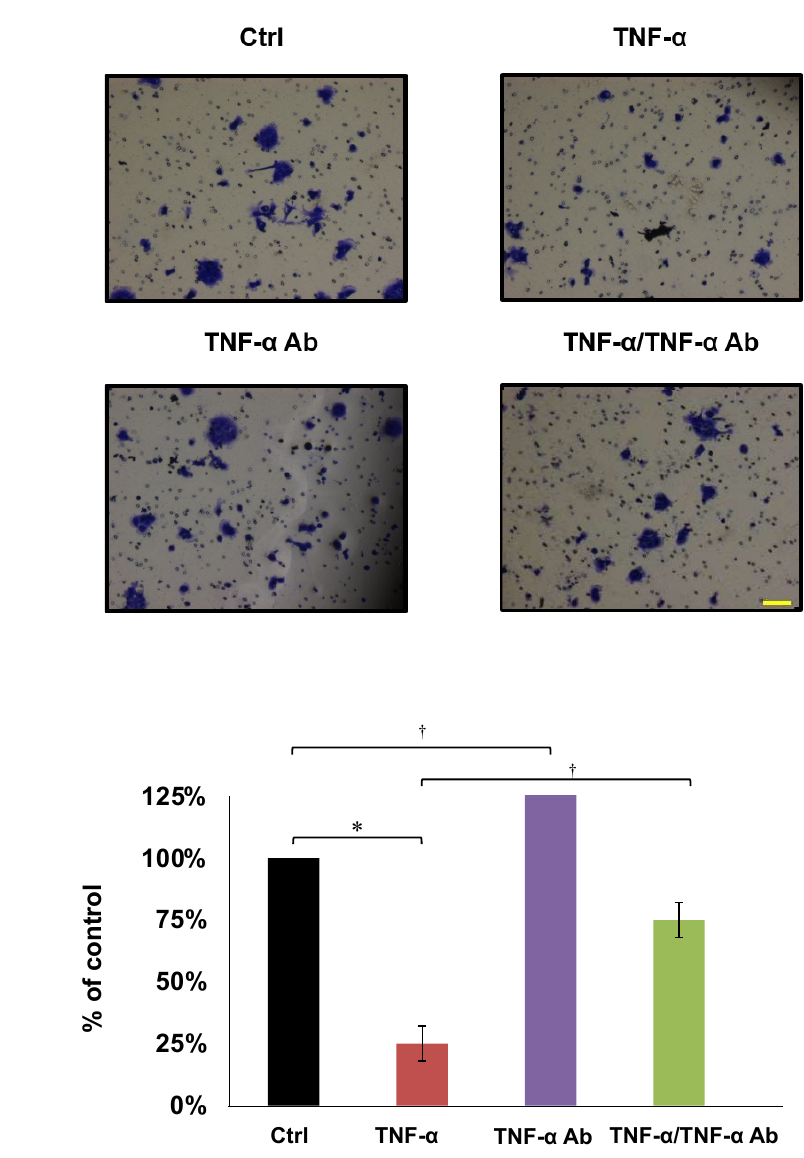
Figure 4. Invasion assays. ( a , b ) Representative COLO205 data. Concentrations of TNF- α and human anti TNF- α Ab are 50 ng/mL and 2 µ g/mL, respectively. * p < 0.01, † p < 0.05. Scale bar represents 100 µm.